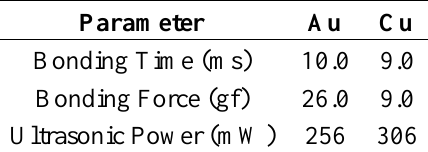
Table 2. Wire bonding